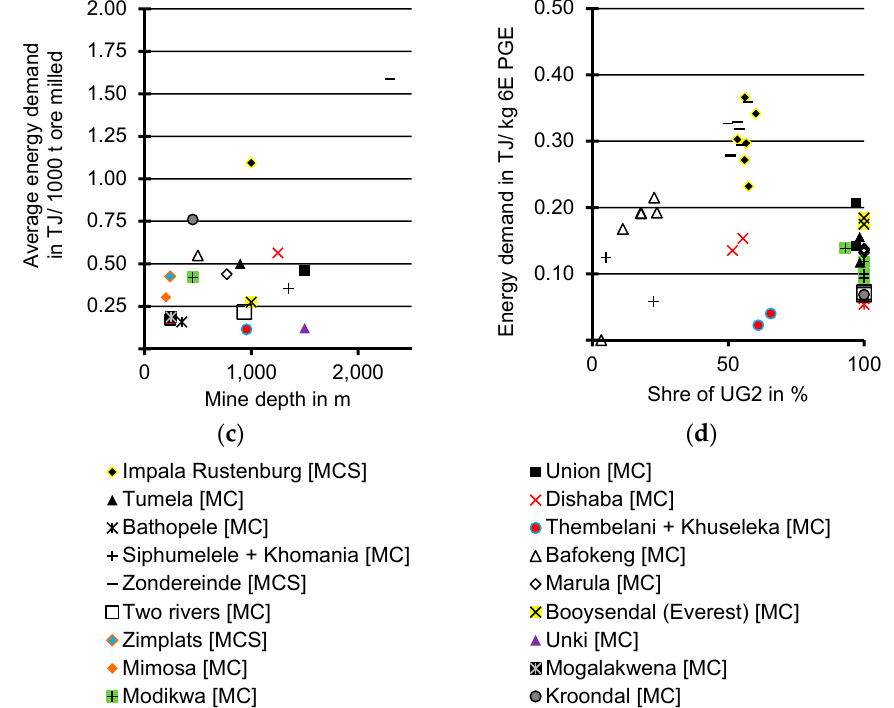
Figure 6. Energy demand per 1000 t ore milled and per kg 6E PGE production plotted over head grade ( a , b ); and per 1000 t ore milled plotted over mine depth ( c ); and the share of UG2 processed ( d ). Data from 2010 to 2015. Regression lines and related R 2 can be found in Figures S2–S7. Abbreviations: MC: Mine and concentrator; MCS: Mine, Concentrator and Smelter. Based on data from [59–62,68,69,73,75,85–89].